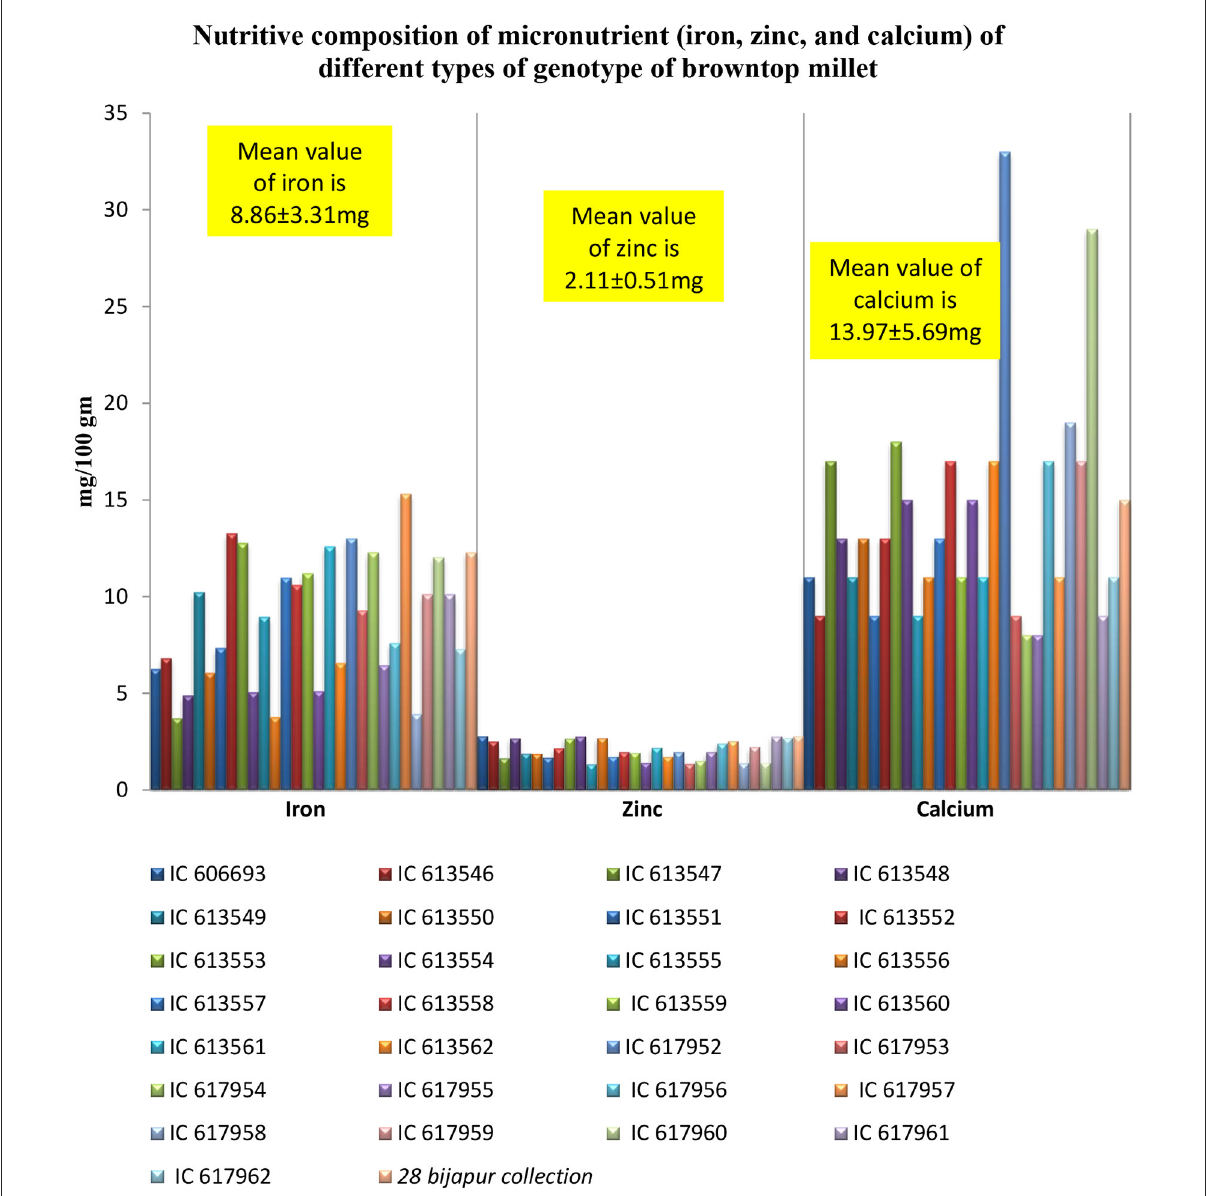
FIGURE6 Nutritive composition of micronutrient (iron, zinc, and calcium) of different types of genotype of browntop millet. Source: Niharika et al. (2020).